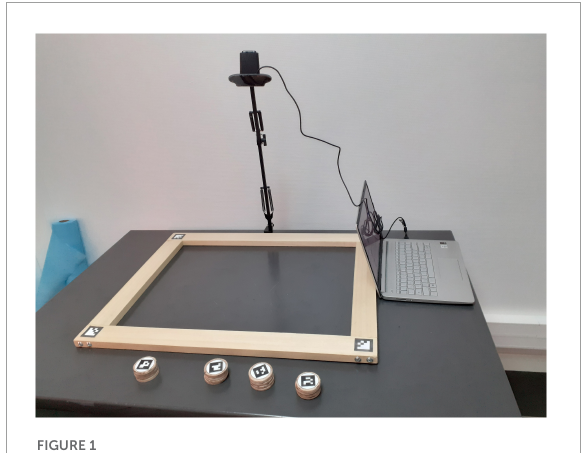
FIGURE1 The Enhanced Baking Tray Task (E-BTT)